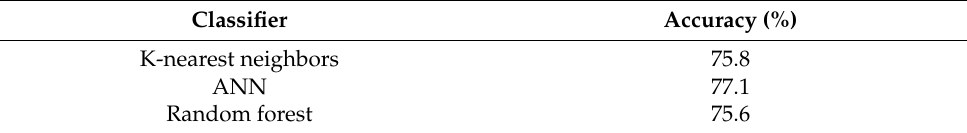
Table 12. Accuracy score for each algorithm: